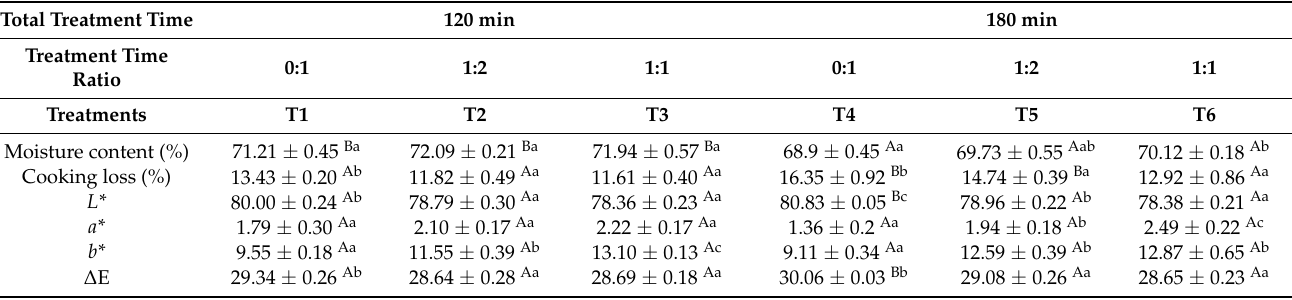
Table 3. Means ± standard deviations of moisture content, cooking loss, and color attributes of chicken breast cooked with different combinations of temperatures and time durations. 120 min 180 min